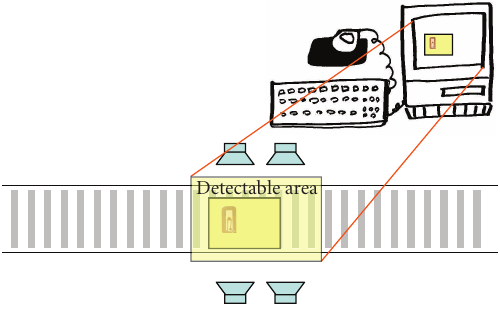
Figure 4: RFID-tagged item on a conveyer belt.